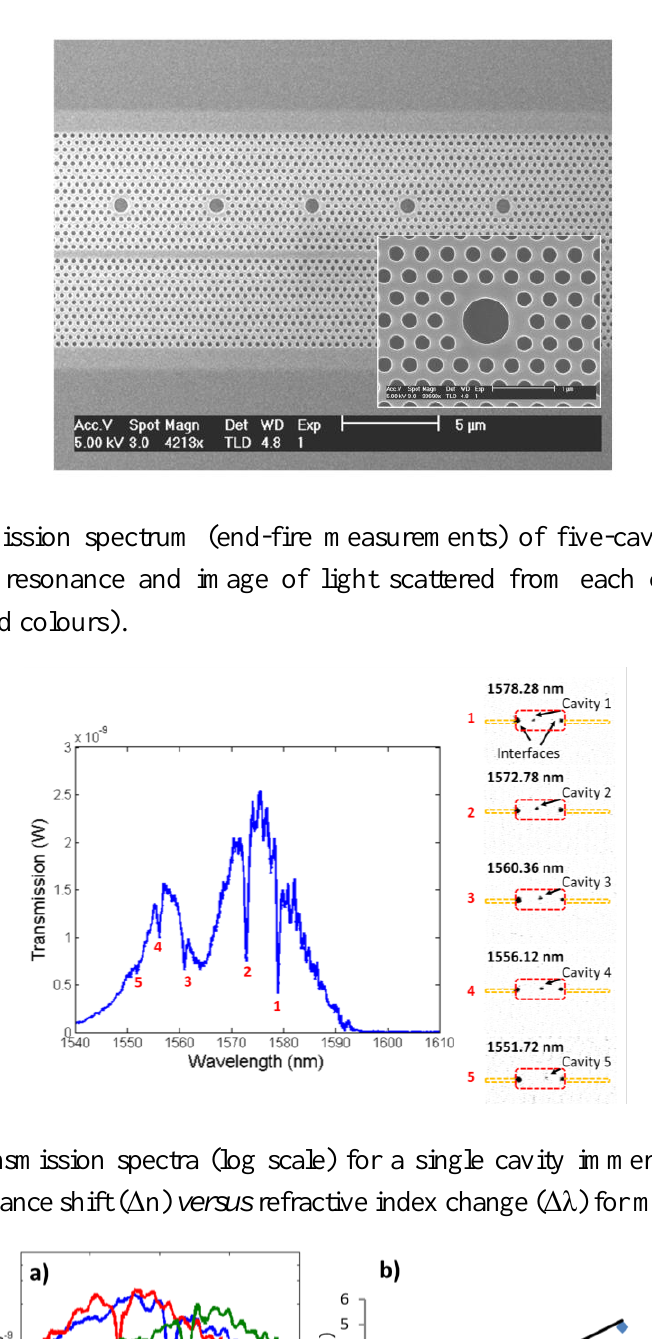
Figure 1. SEM images of fabricated five-cavity array.